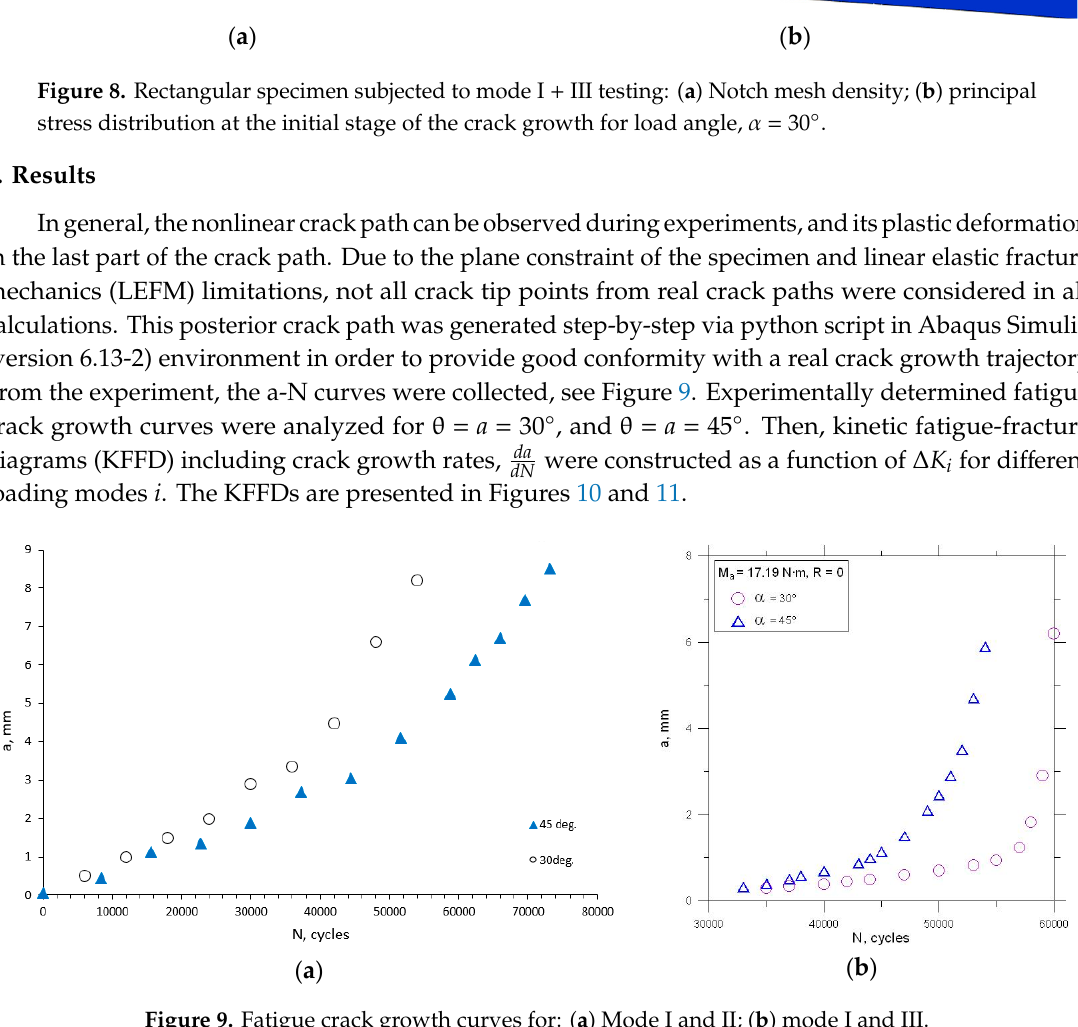
Figure 9. Fatigue crack growth curves for: ( a ) Mode I and II; ( b ) mode I and III.